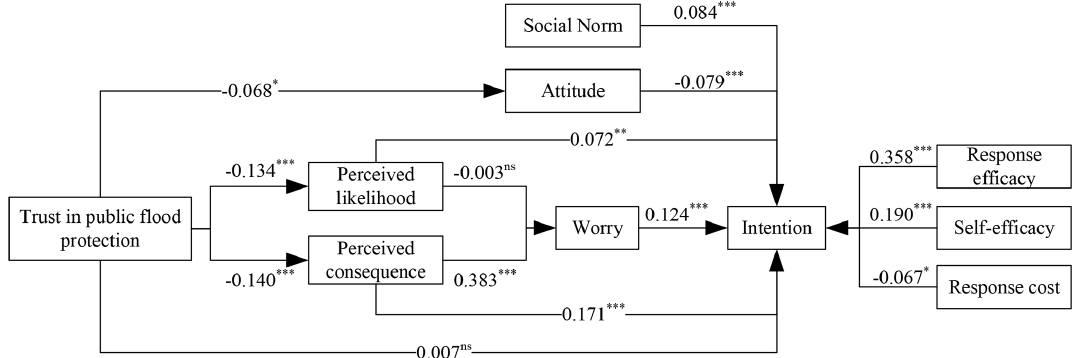
Figure 4. Significance test results of the structural model path coefficient. Only the statistically significant direct effects are reported; n = 857; path significance is as follows: ∗∗∗ p < 0.001. ∗∗ p < 0.01. ∗ p < 0.05. ns p >